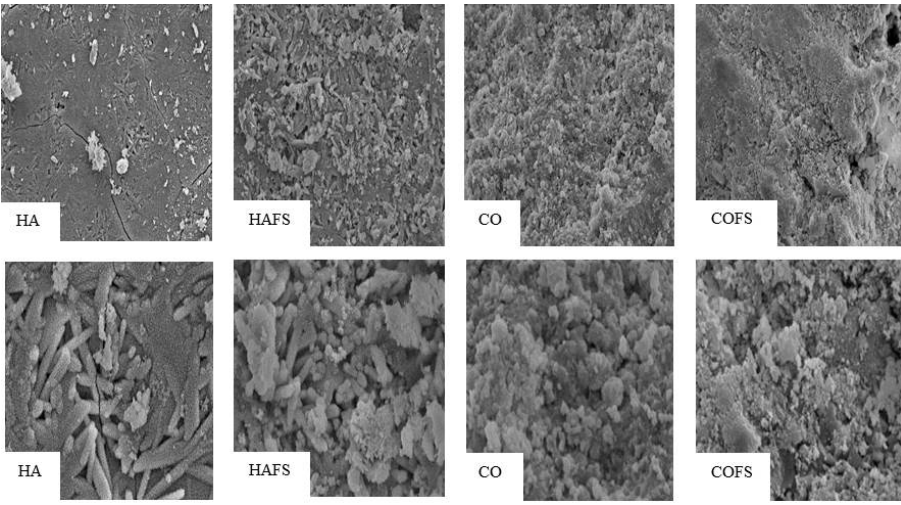
Figure 4. SEM analysis of all groups at magnification ×1000 (upper) and ×4000 (lower).